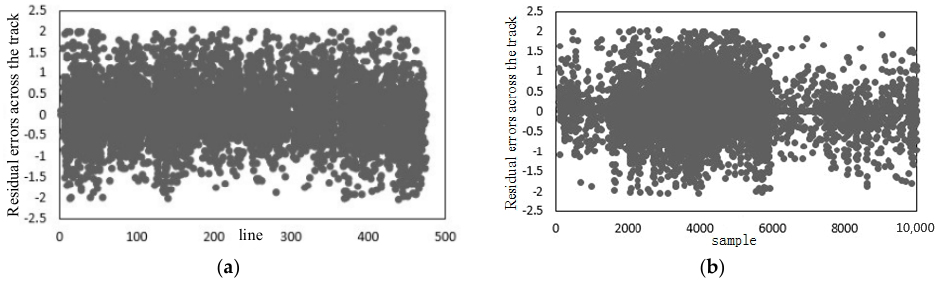
Figure 9. Residual errors after the calibration of the whiskbroom angle parameters: ( a ) Residual errors along the track (whiskbroom direction); ( b ) residual errors across the track (whiskbroom direction).